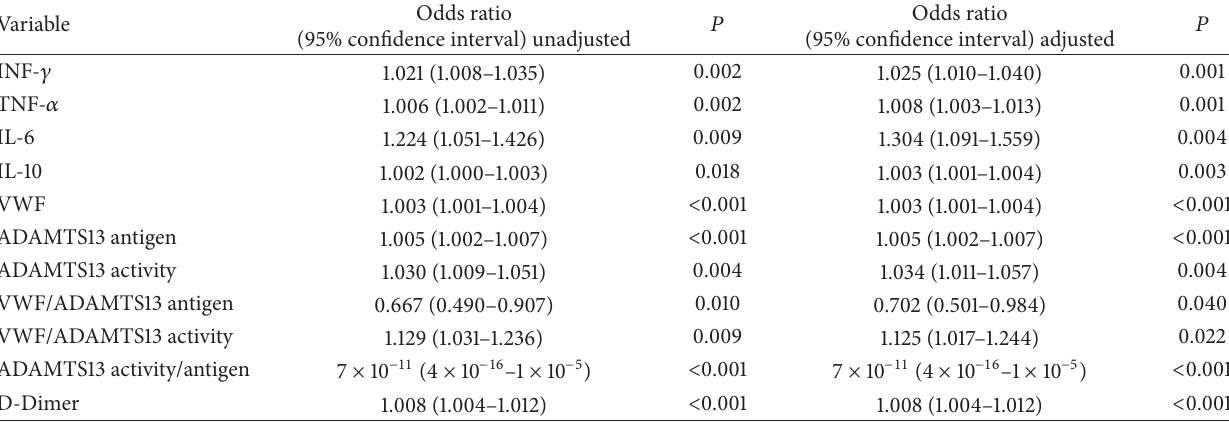
Table 2: Association between haemostatic and inflammatory biomarkers with chronic kidney disease in type 1 diabetic patients.